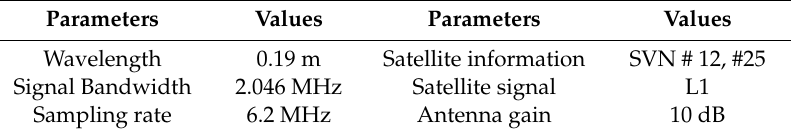
Figure 15. Illustration of the experimental scene and setups. Table 3. Preliminary experimental parameters with GPS signals.